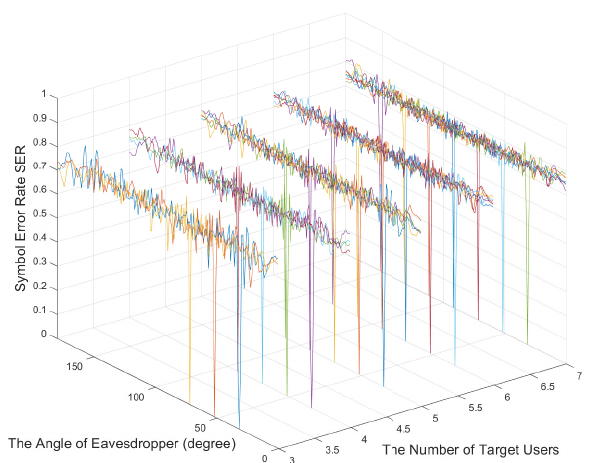
Figure 14. The relationship between the number of target users and the symbol error